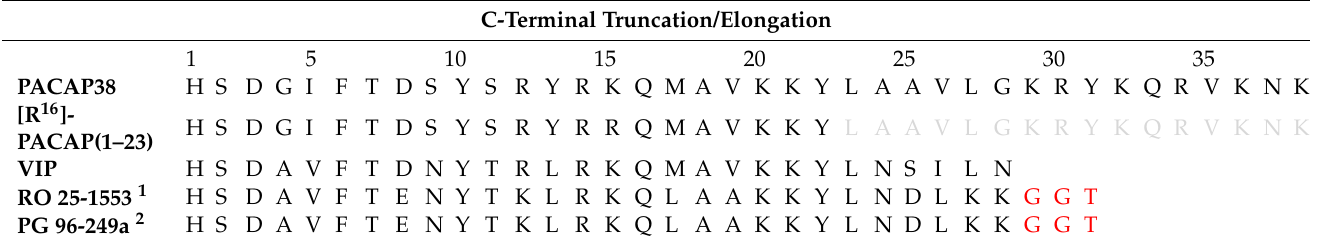
Table 4. Truncation (grey) and elongation (red) peptide length contribute to VPAC1R/VPAC2R- selective peptide